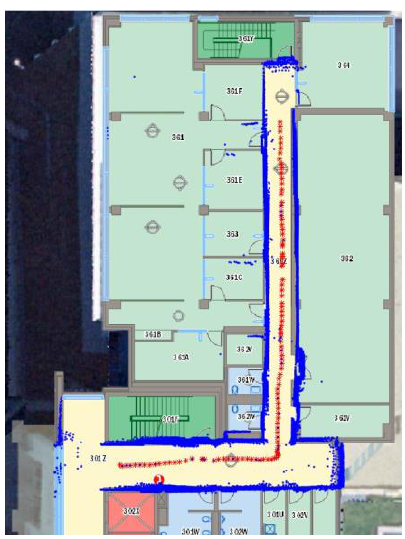
Figure 9. Mapping and position results of the proposed IRKF